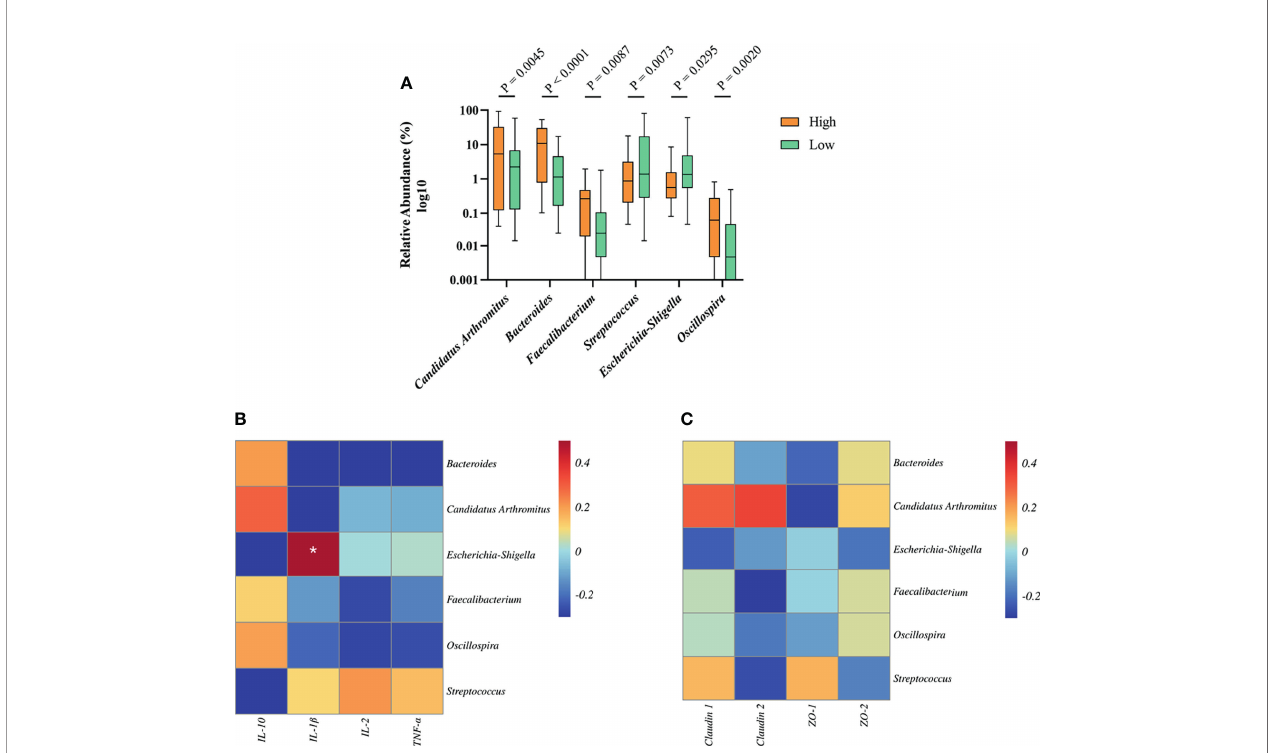
FIGURE 6 | The relationship between BW-related bacteria and immunity of Muscovy ducks in high and low groups. Two hundred newly hatched ducklings were fed commercial feeds for 70 days before the ileal content samples were collected from each ileum segment. (A) The indicated OTUs was identi fi ed from the genera with signi fi cantly different abundance between the high and low groups (n = 40). Data were expressed as mean ± SD (n = 40) and analyzed by unpaired two-tailed Students ’ t-test. The correlation heatmap was based on the Pearson algorithm to analyze the correlation between BW-related bacteria and cytokines (B) as well as tight junctions (C) of Muscovy ducks in high and low groups (n = 40). * P <